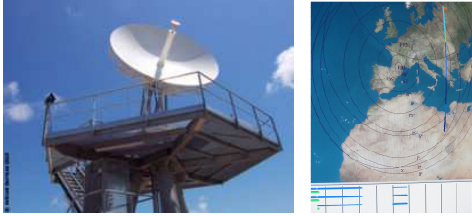
Figure 6 : PLEIADES Receiving